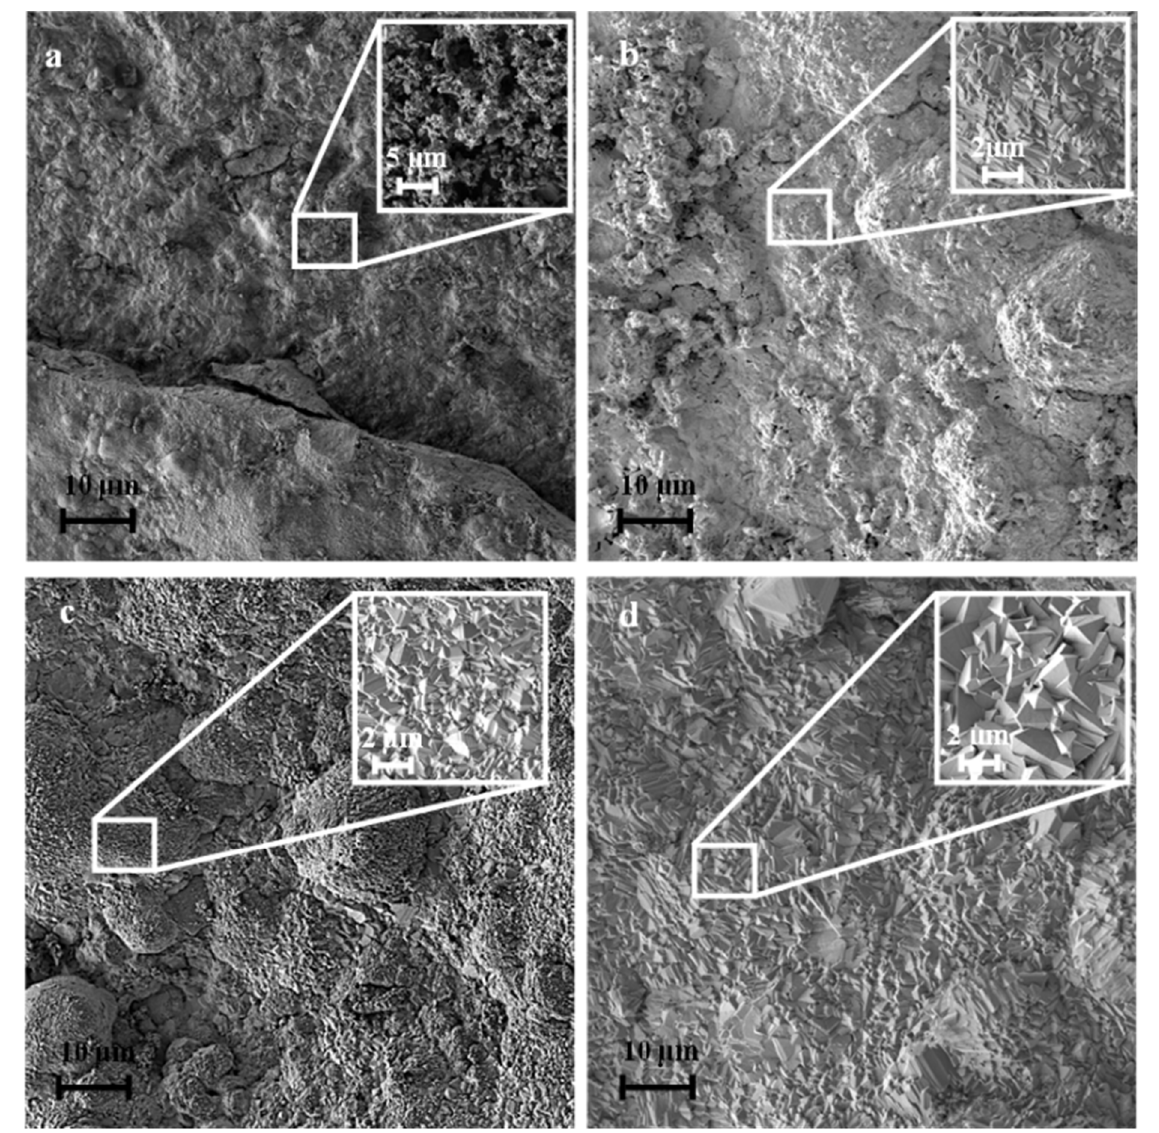
Figure 6. Surface micrograph of ( a ) bare steel, ( b ) CoMnO30, ( c ) CoMnO35, ( d ) CoMnO38 since oxidation measurement.